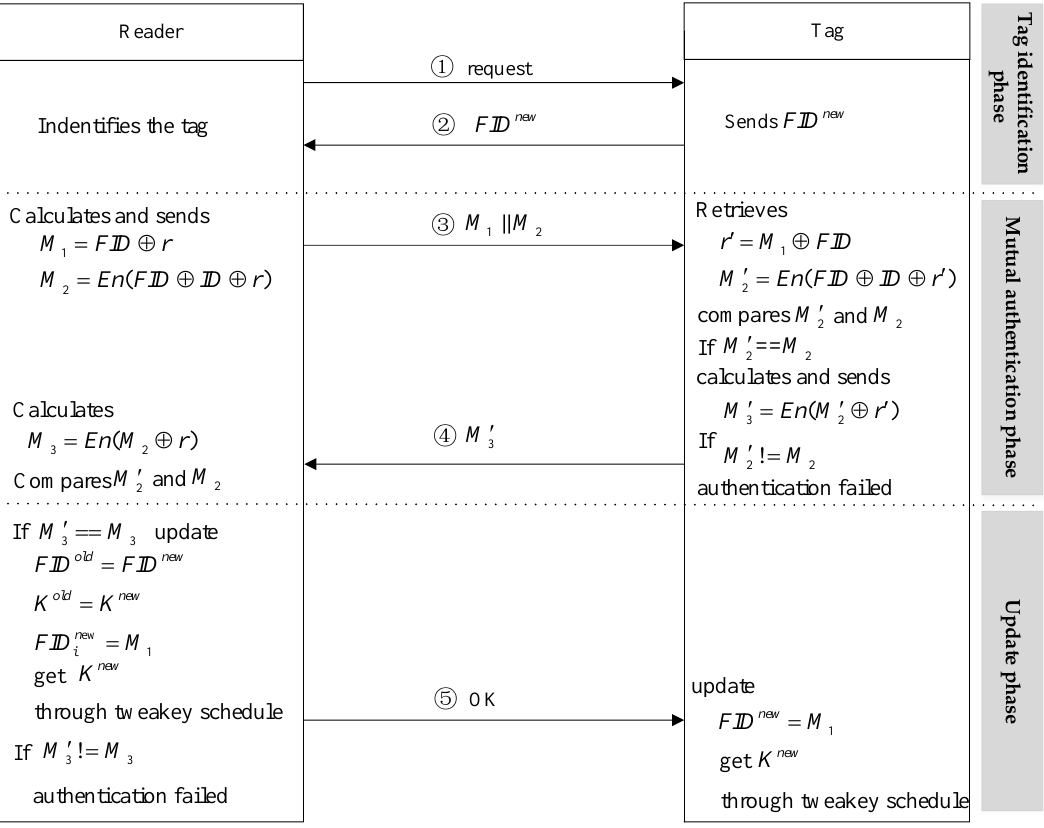
Figure 2. The authentication process of LRSAS.